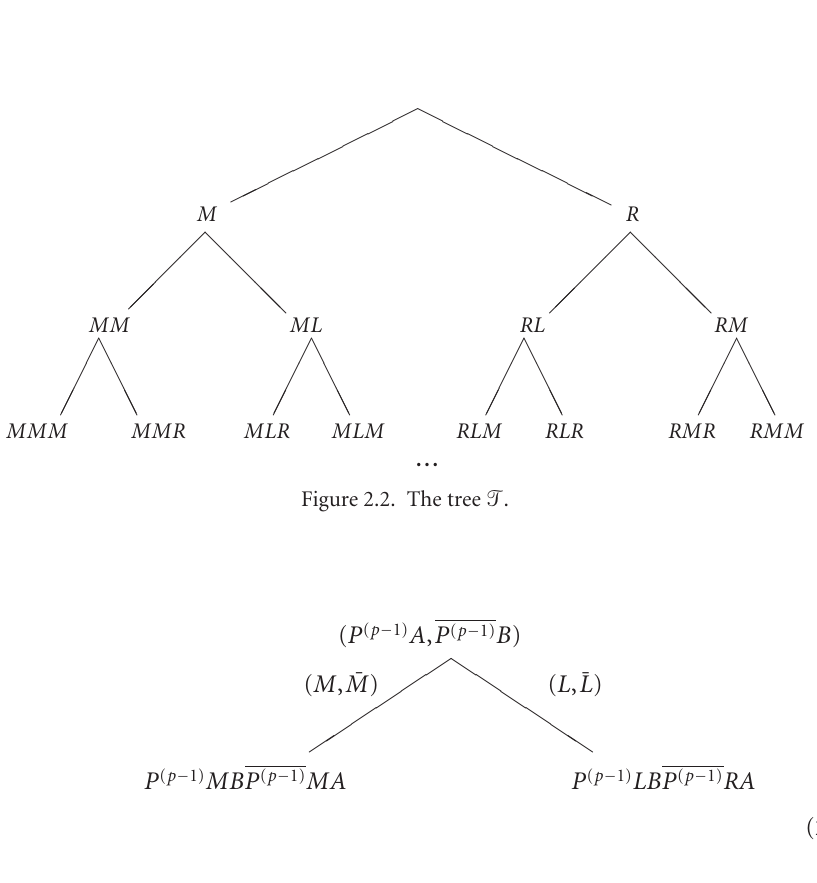
Figure 2.2. The tree (cid:3)